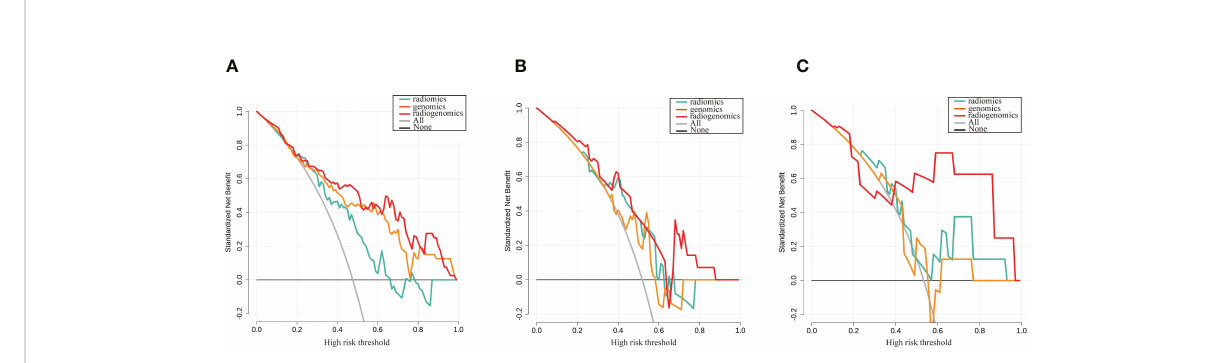
FIGURE 5 Decision curve analysis for the genomics, radiomics and radiogenomics models of LNM prediction in breast cancer. (A) Training group; (B) Testing group; (C) External validation group. The y-axis measures the standardized net bene fi